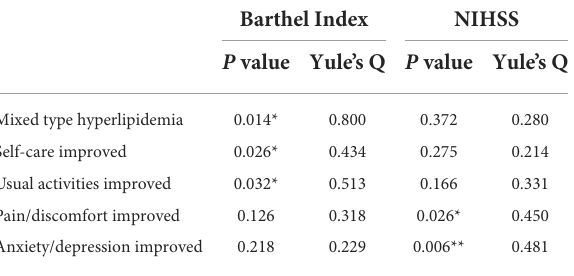
TABLE 3B The association between baseline biochemistry/EQ-5D and outcome assessment.